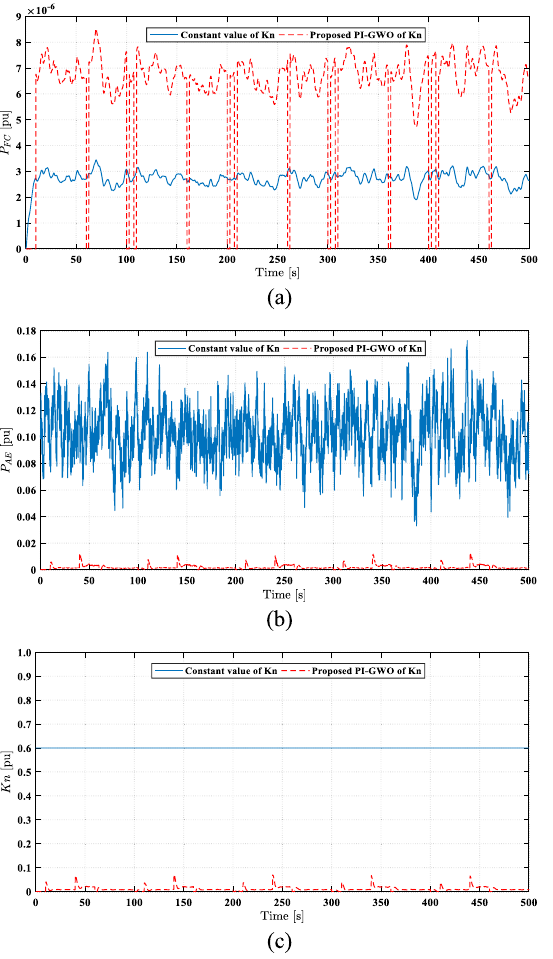
Fig. 16 The Case 3 response of a fuel cell power, b power fed to AE, c value of Kn